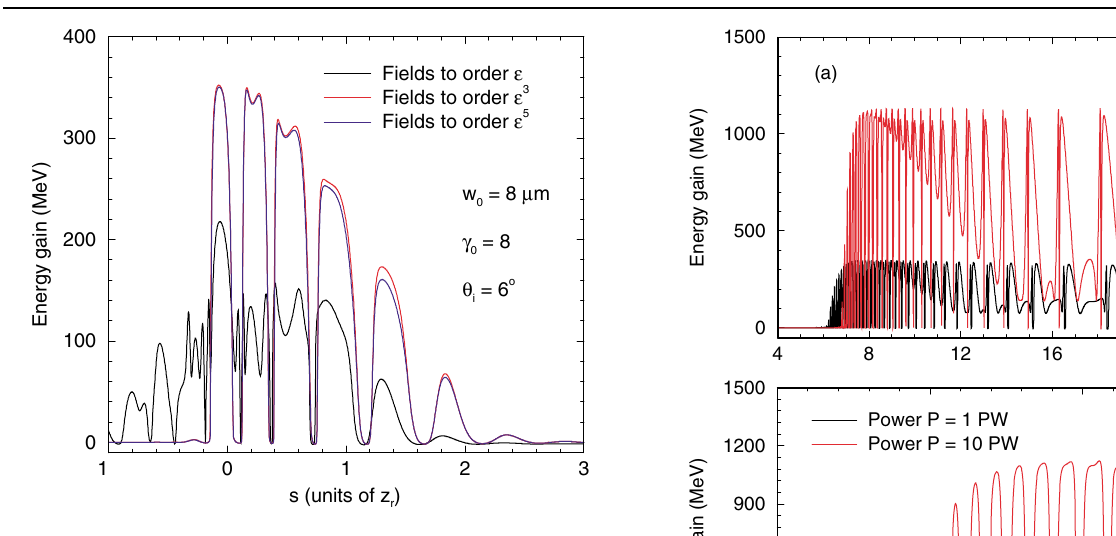
(cid:3) (cid:2)(cid:4) s (cid:2) 0